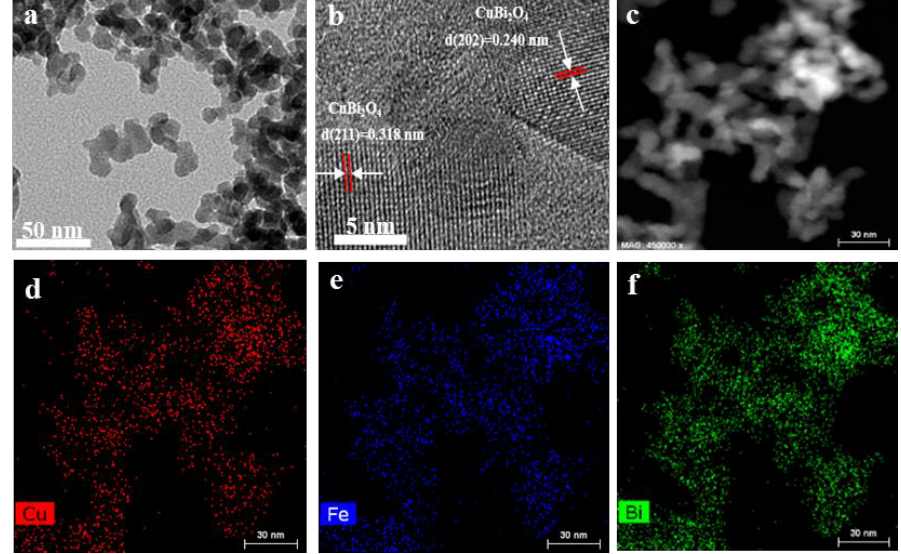
Figure 3. ( a ) TEM image; ( b ) HRTEM image; ( c ) TEM image of the selected mapping area and the corresponding elemental mapping of ( d ) Cu, ( e ) Fe, ( f ) Bi of the T-CBO/A-BFO (1:1). The arrows pointed to the interplanar spacing for different CBO planes. Nanomaterials 2020 , 10 , x FOR PEER REVIEW